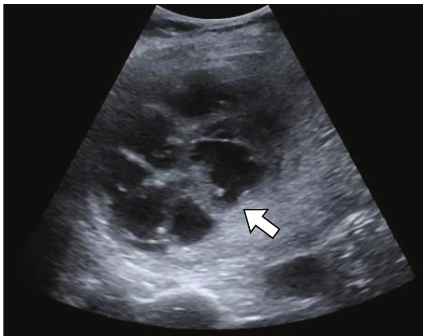
Figure 1: Right upper quadrant ultrasound showing a complex hepatic lesion with multiple internal septations (arrow).